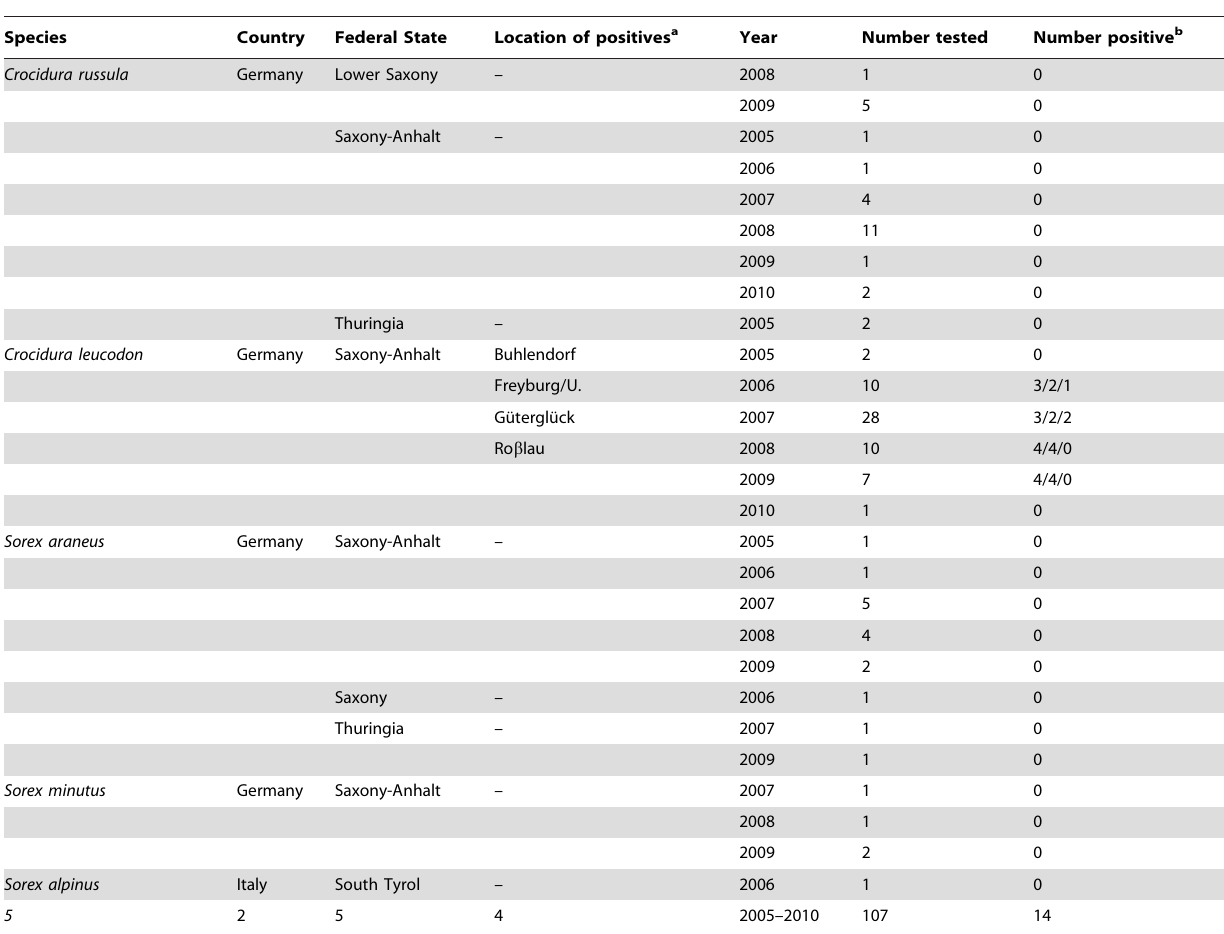
Table 1. Overview of shrew collection and individuals found to be positive for